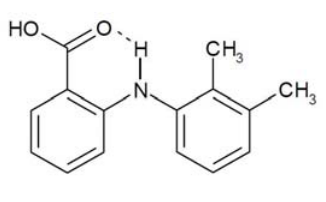
Figure 2. Mefenamic